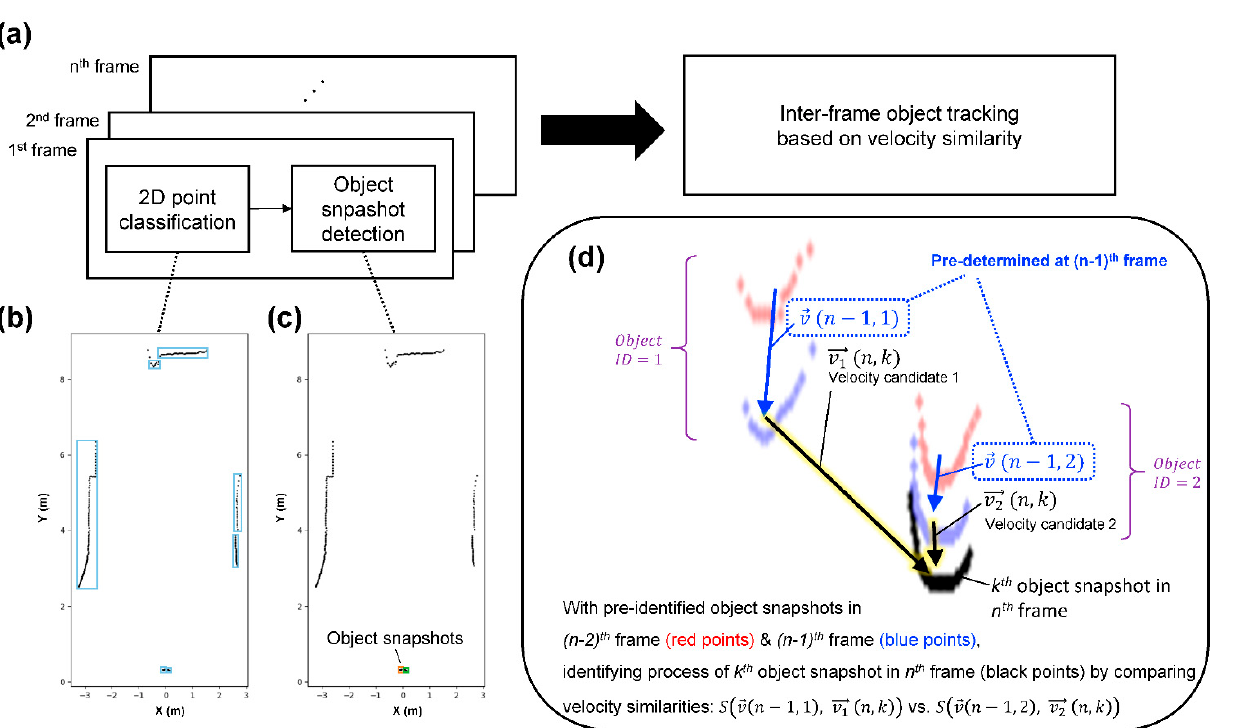
→ → v 1 ( n , k ) and v 2 ( n , k ) , of the k th object → → v ( n − 1, 1 ) and v ( n − 1, 2 ) , of object ID 1 and 2